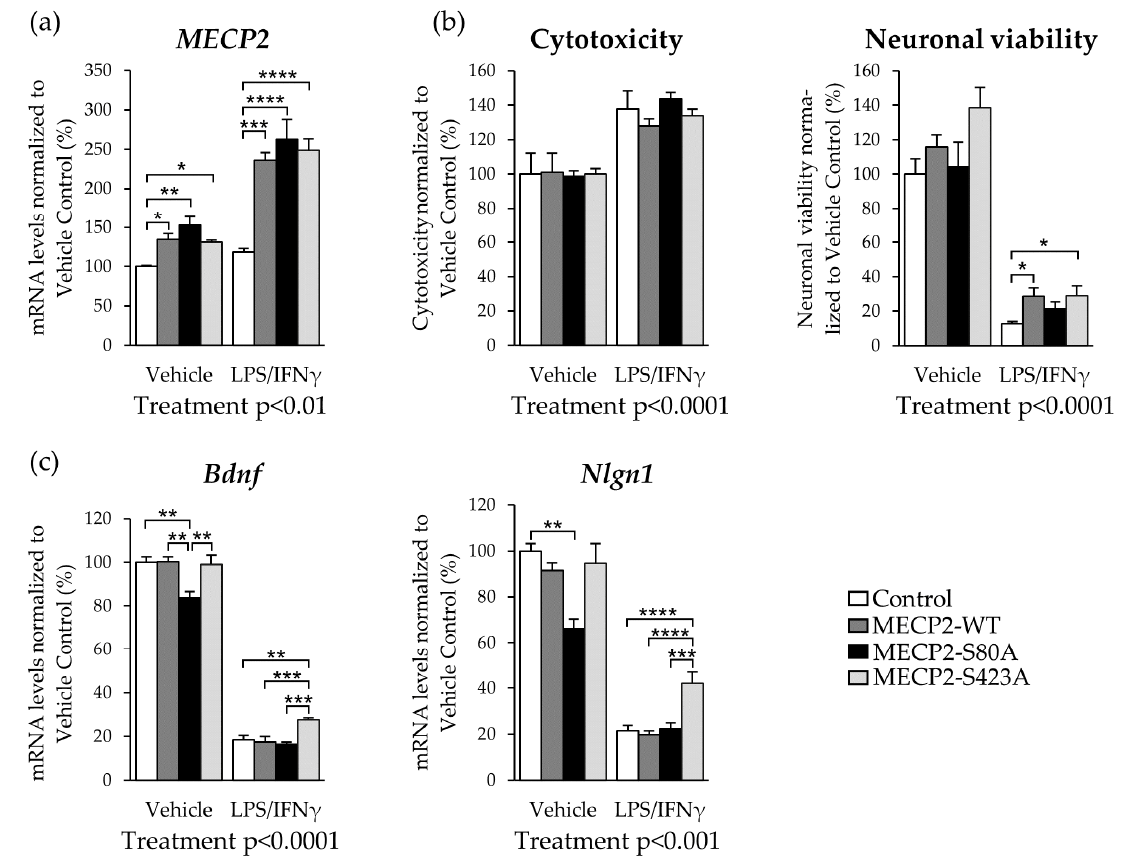
Figure 5. Expression of MECP2-S423A in mouse primary cortical neurons co-cultured with BV2 cells enhances neuronal viability and leads to an increased expression of brain-derived neurotrophic factor ( Bdnf ) and neuroligin 1 ( Nlgn1 ) upon LPS/IFN γ -induced activation. Cortical neurons were transduced with lentivirus vectors after four days in vitro (DIV4) encoding MECP2-WT-Myc, MECP2-S80A-Myc, MECP-S423A-Myc, or plasmid backbone only (Control). BV2 cells were added 48 h after the neuronal transduction and inflammation was induced with LPS (200 ng/mL) and IFN γ (20 ng/mL). ( a ) β -actin -normalized MECP2 (mouse and human) mRNA expression in vehicle and LPS/IFN γ -treated neuron-BV2 co- cultures. No treatment effect in comparison to Control group was detected. ( b ) Cytotoxicity (left) and neuronal viability (right) were assessed 48 h after LPS/IFN γ treatment. Cytotoxicity was determined by measuring lactate dehydrogenate (LDH) levels in the conditioned medium. Neuronal viability was assessed by MAP2 immunostaining assay. ( c ) β -actin - normalized mRNA expression of Bdnf and Nlgn1 upon LPS/IFN γ -induced inflammation in neuron-BV2 co-cultures. Data are shown as Mean + SEM of n = 6–8 of two independent experiments, n = 3 for cytotoxicity assay . One-way ANOVA, post-hoc LSD or Kruskal–Wallis and Dunn’s multiple comparisons test. For Treatment effect: Independent-samples t-test or independent samples Mann–Whitney U test was used; **** p < 0.0001, *** p < 0.001, ** p < 0.01, * p < 0.05.